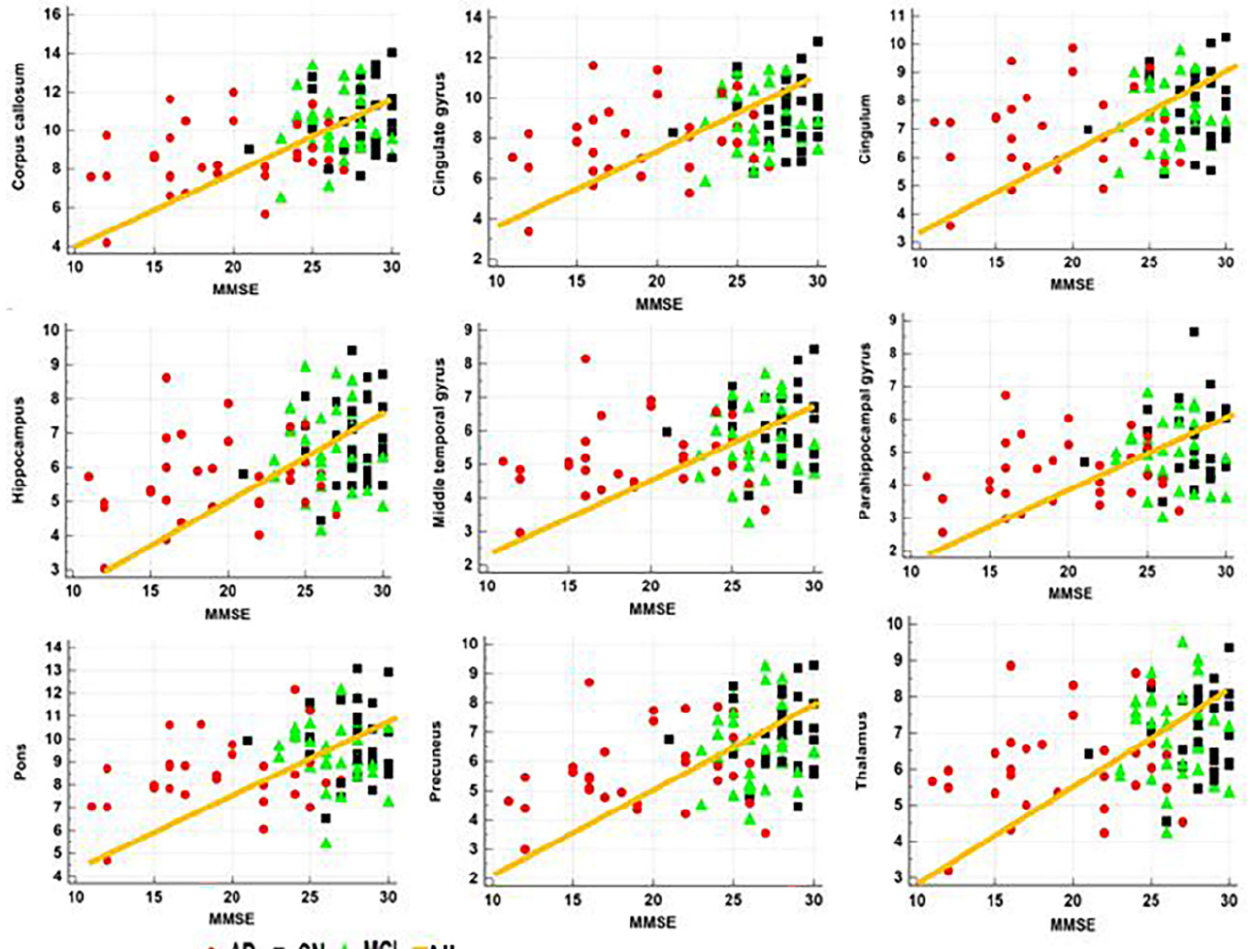
Figure 5. Results of the correlation analysis between the apparent MWF values in the specific brain areas and MMSE